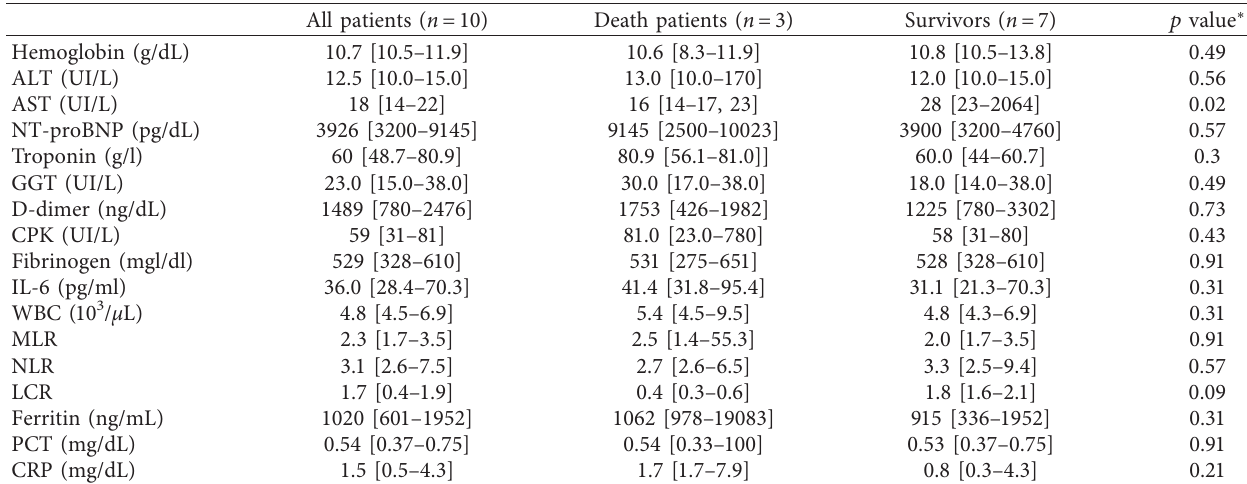
Figure 1: Interleukin-6 level reduction at 14days according to vital status. Table 4: Laboratory data at diagnosis according to vital